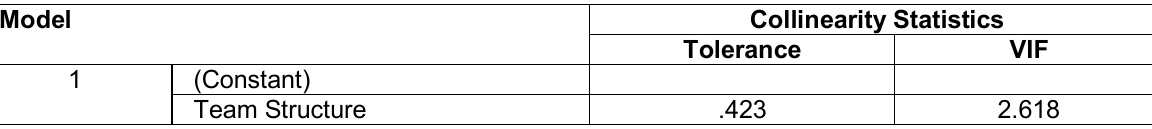
Table 2: Multicollinearity Test